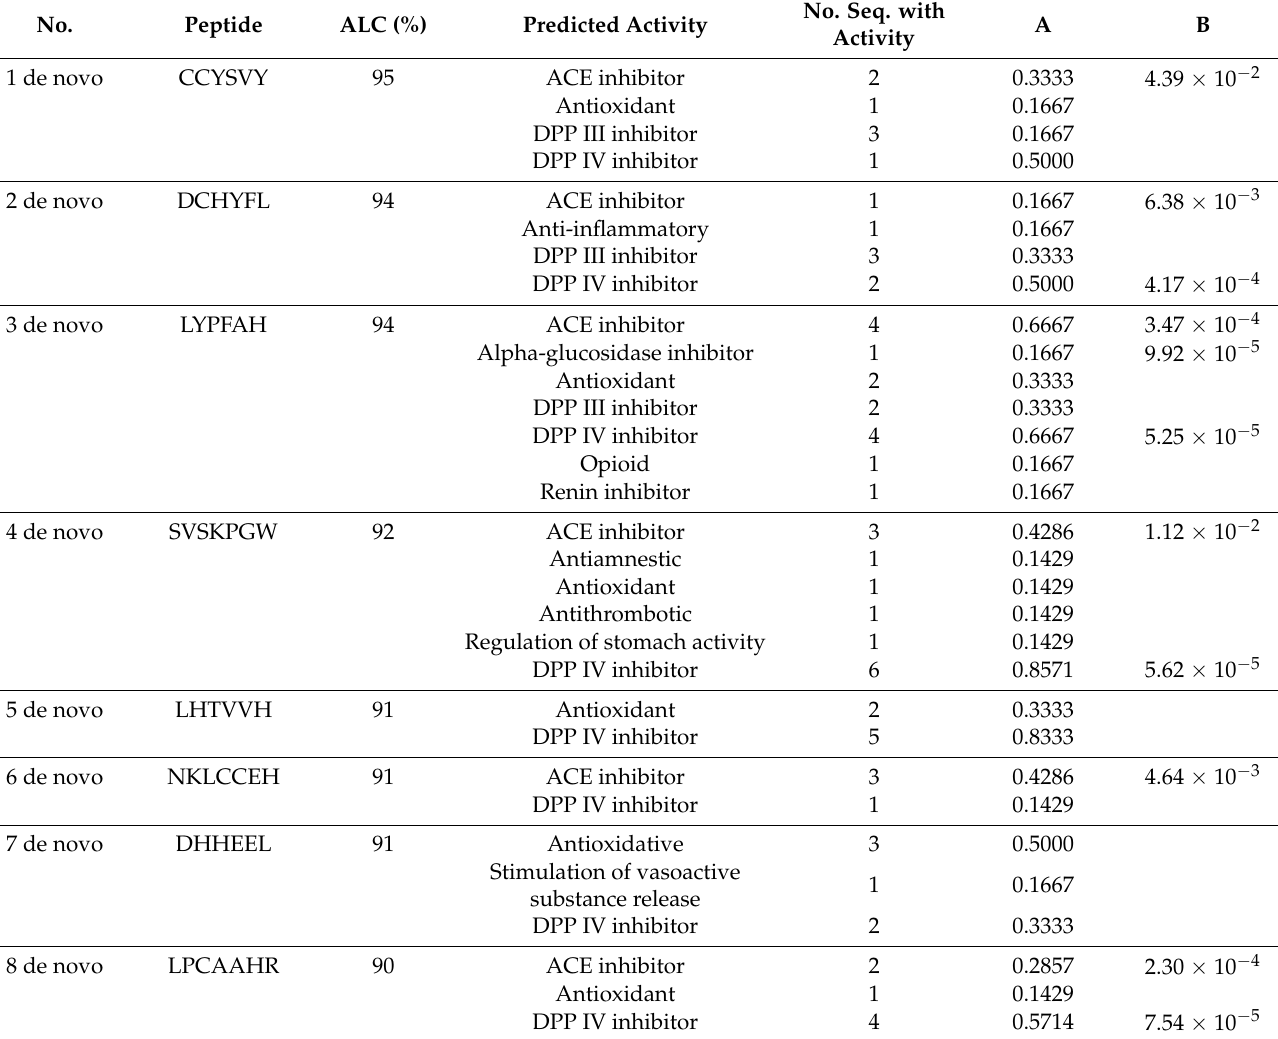
Table 5. Predicted activity of endogenous peptides identified in virgin olive oil by de novo sequencing using BIOPEP-UWM database of bioactive peptides: ACE, angiotensin converting enzyme; DPP III, dipeptidyl peptidase-III; DPP IV, dipeptidyl peptidase-IV; A, ratio of number of sequences with predicted activity to number of amino acids; B, potential biological activity of the peptide ( µ M − 1 ) theoretically calculated from previous bioactive referenced data. A and B values obtained from BIOPEP-UWM